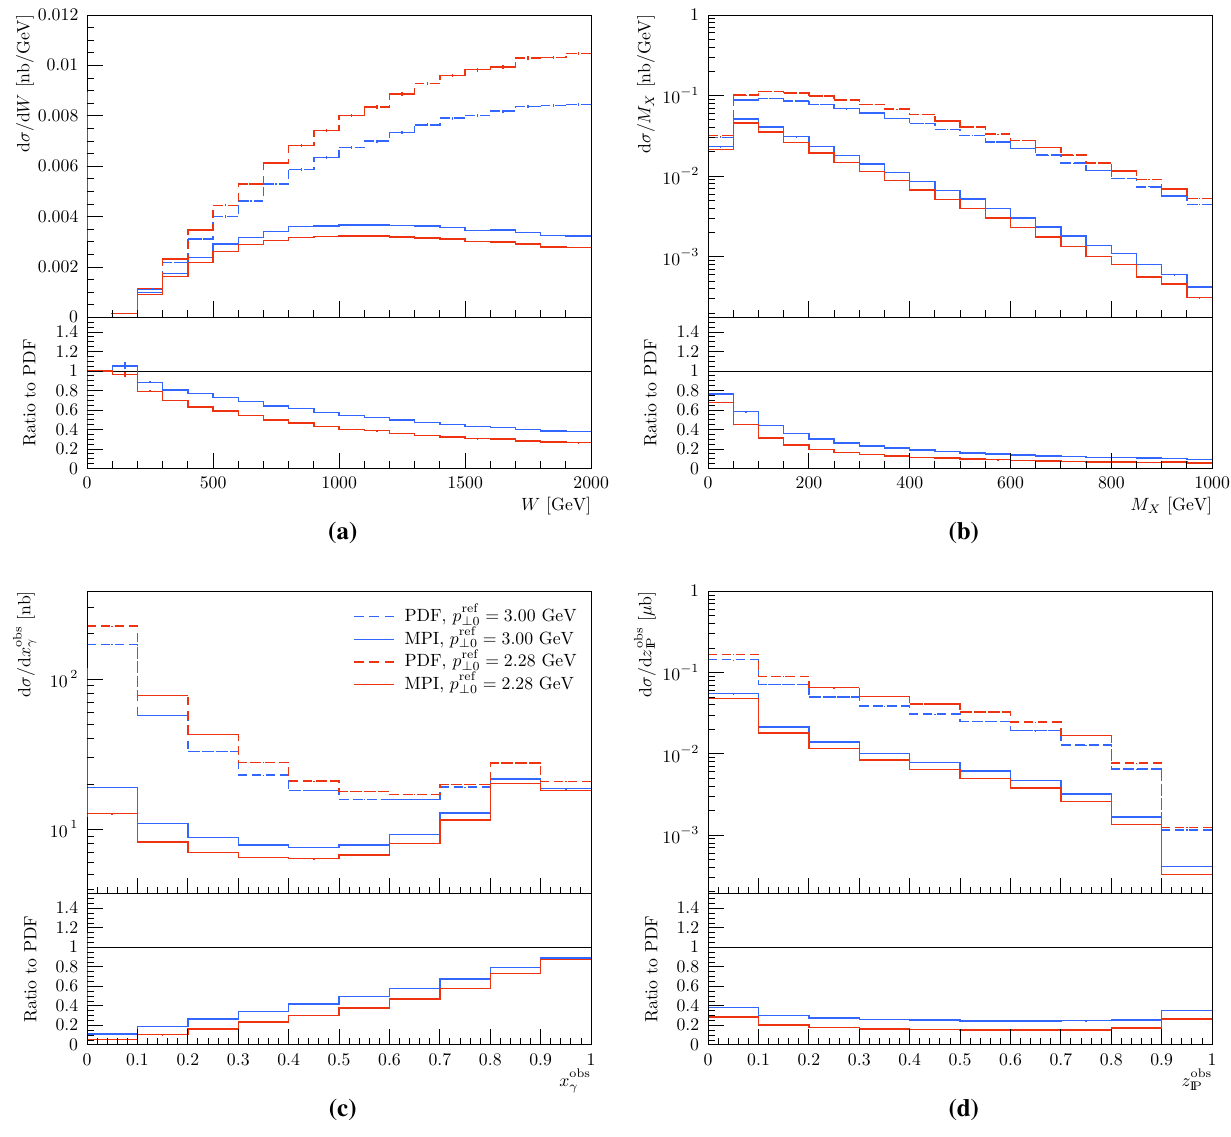
Fig. 17 Cross section for diffractive dijets in ultra-peripheral pp collisions for observables W ( a ), M X ( b ), x obs γ ( c ) and z obs P ( d ). Vertical bars denote the statistical uncertainty in the MC